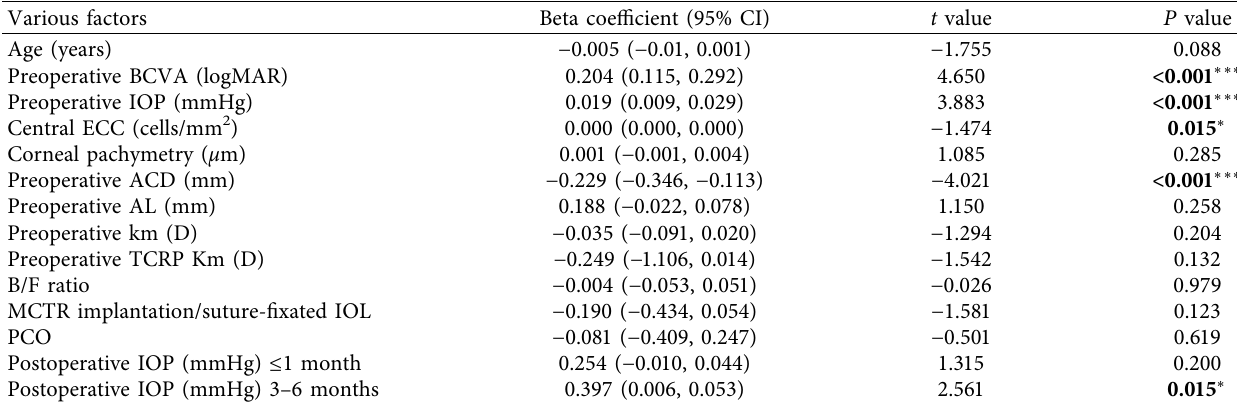
Table 3: Univariate analysis of factors associated with postoperative BCVA at 3–6 months.